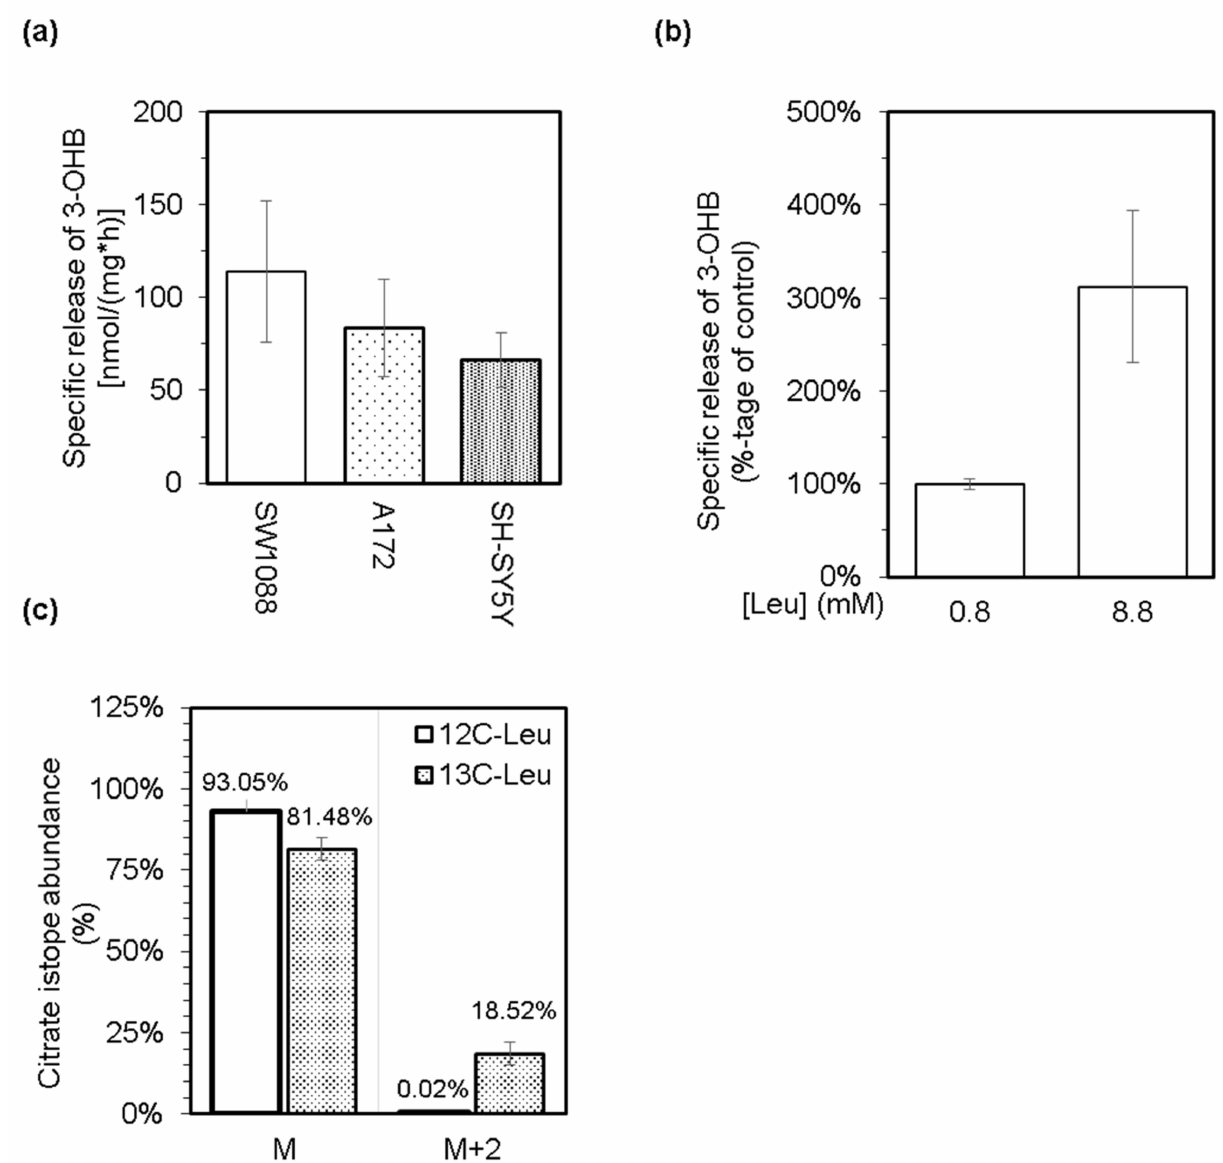
Figure 3. Levels of 3-hydroxybutyrate (3-OHB) in culture media from glioma (SW1088), glioblastoma (A172), and neuroblastoma (SH-SY5Y) cells were enzymatically estimated, and subsequently, the obtained values were used to calculate the specific release of 3-OHB ( a ). The effect of an increased level of leucine in culture medium (up to 8.8 mM) of neuroblastoma (SH-SY5Y) cells on their capacity to release 3-OHB ( b ). LC-MS was used to estimate the abundance of citrate isotopes released into the culture media from glioma cells (SW1088), which were incubated in a minimal medium supplemented with 25 mM glucose and either 0.8 mM leucine (12C-Leu) or 0.8 mM leucine- 13 C 6 (13C-Leu; ( c )). Group M represents the normal molar mass of citrate (191,124 g/mol), and group M + 2 represents the molar mass of citrate increased by two units (193,124